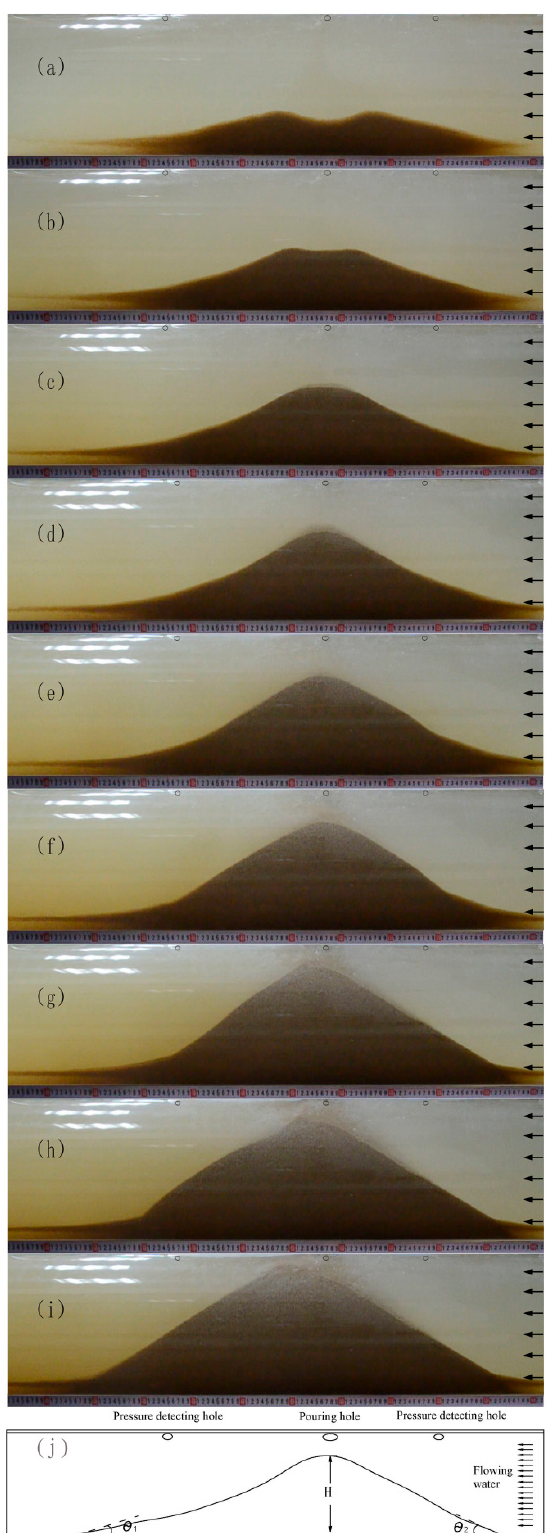
Figure 4. Series of diagrams on formation of deposit with cone shape. Poured aggregate: ( a ) 1500 g; ( b ) 3000 g; ( c ) 4500 g; ( d ) 6000 g; ( e ) 7500 g; ( f ) 9000 g; ( g ) 10,500 g (10.5 kg); ( h ) 12,000 g (12 kg); and ( i ) 13,500 g (13.5 kg). ( j ) Schematic diagram of angle of deposited aggregate with cone shape.